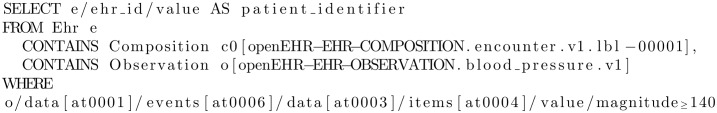
Type 3 query example with two levels of containment.The number of CONTAINS clauses gives away the query level.